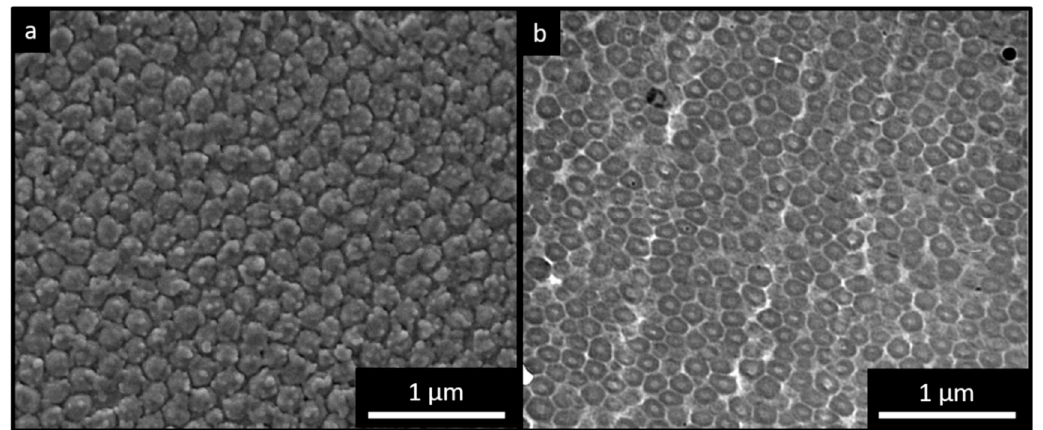
Figure 4. ( a ) SEM image: surface of PS@P(NFHMA- co -TFEA- co - n BuA) opal film; ( b ) TEM image: ultra-thin cut of the cross-section of a PS@P(NFHMA- co -TFEA- co - n BuA) opal film.